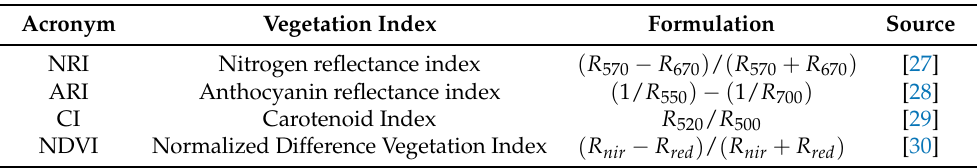
Table 3. Vegetation indices non-related to the estimation of moisture content, including their acronym, name, formulation and